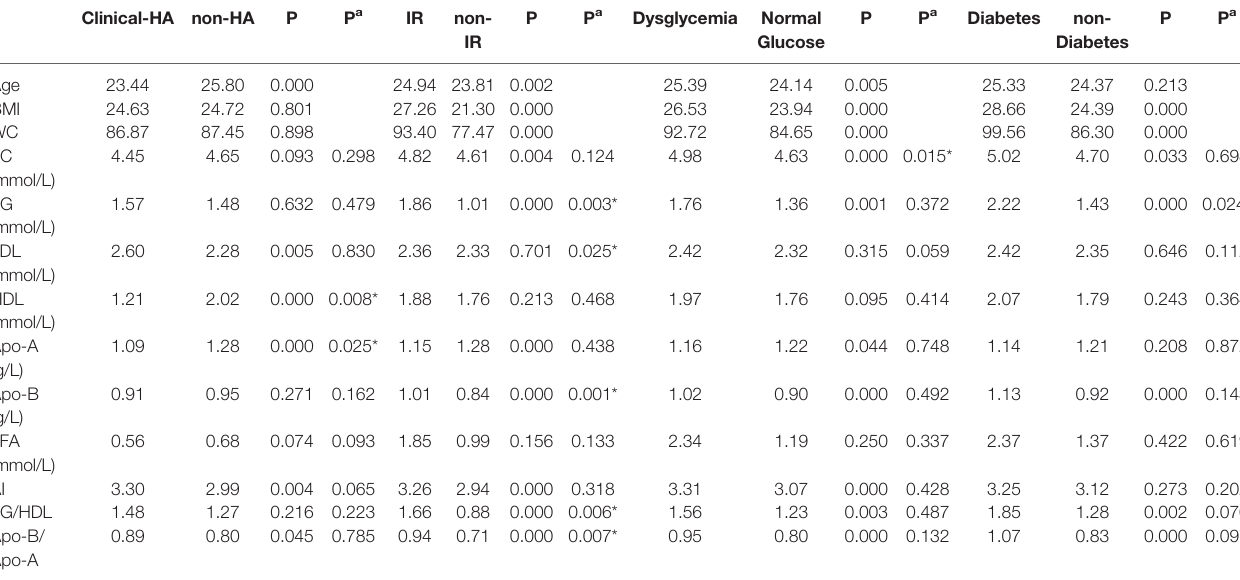
TABLE 3A | Comparison of serum lipid pro fi les in PCOS patients with or without hyperandrogenism, insulin resistance, dysglycemia, and diabetes. Clinical-HA non-HA